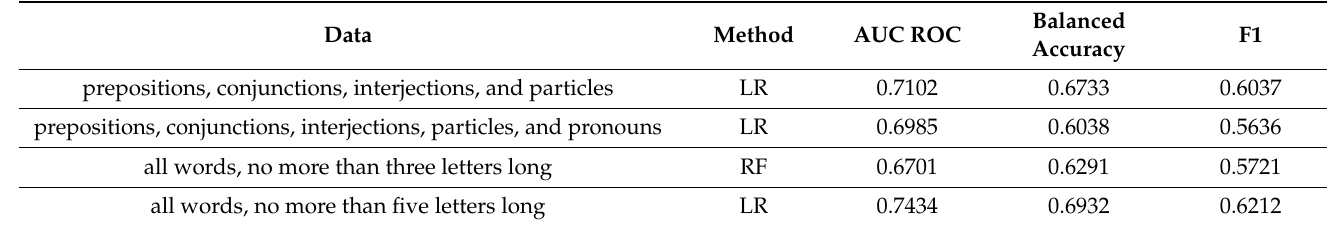
Table 7. The classification results by service and short words for the main data set.